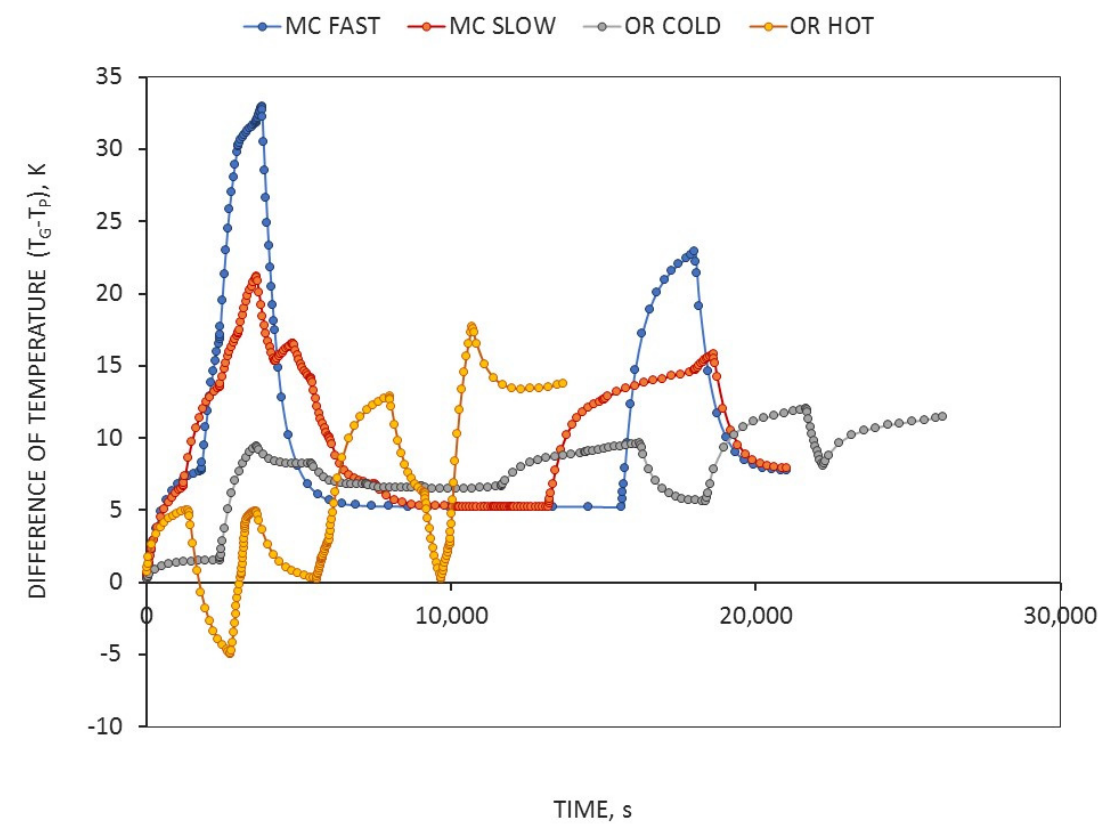
Figure 7. Time-dependent temperature differences between the internal and external surfaces at the middle bottom of the boiler drum for the considered startup scenarios.